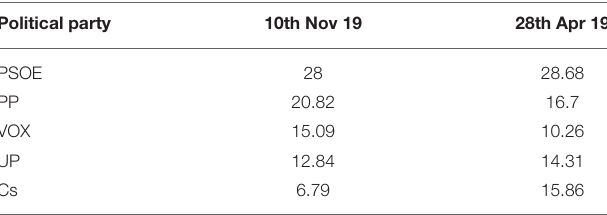
TABLE 1 | Percentage of votes obtained by the most voted parties in the 2019 general elections. Political party